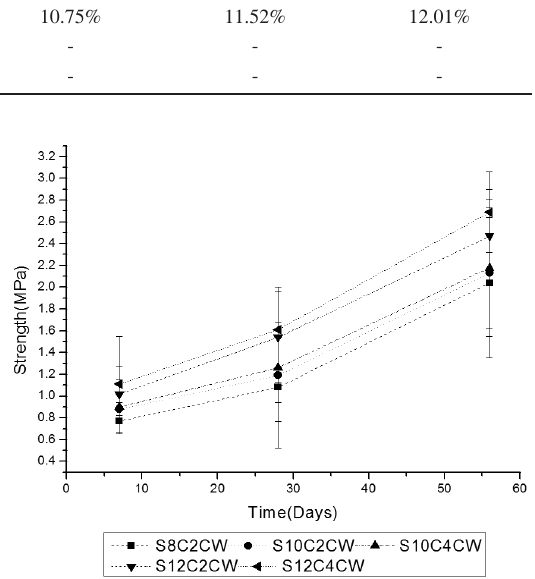
Figure 5. Strength of soil-cement and CW bricks.